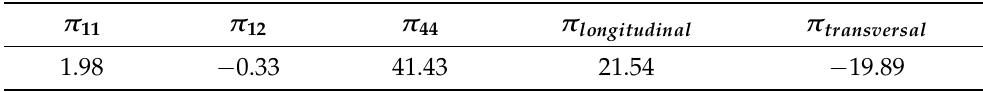
Table 2. Piezoresistive coefficients π in [10 − 11 Pa − 1 ] of the piezoresistors at 25°C. π longitudinal